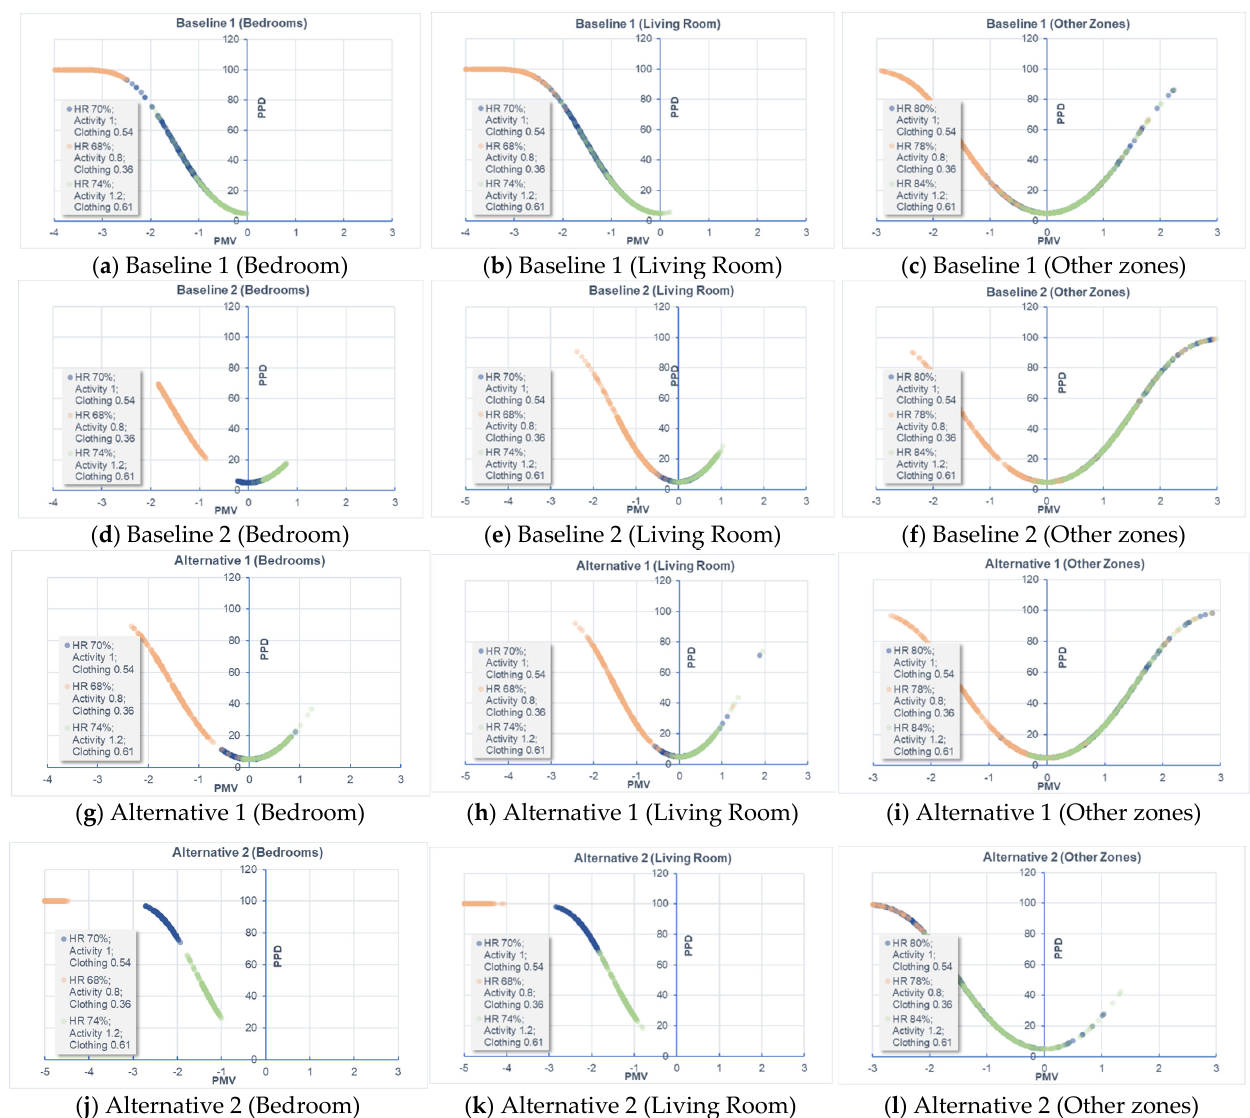
Figure 14. PMV versus PPD for different design options.